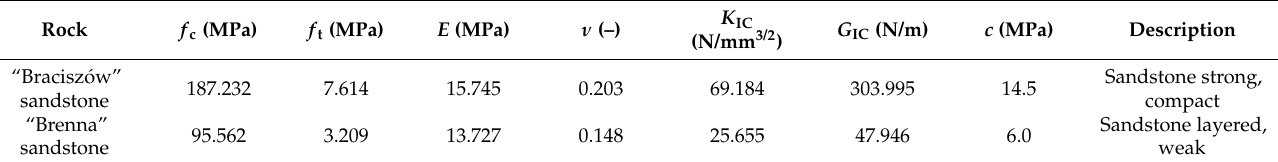
Table 1. Physical and mechanical parameters of the studied rocks.